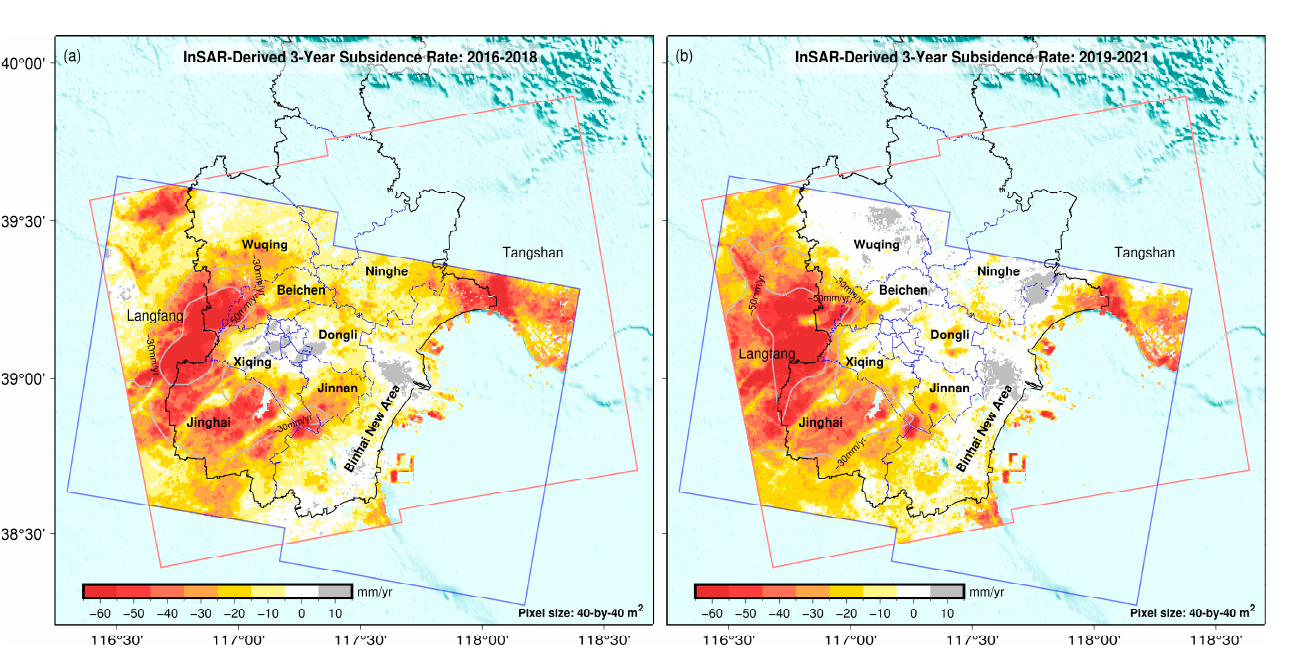
Figure 10. Comparisons of subsidence rates before and after the SNWD. ( a ) InSAR-derived 3-year subsidence rates from 2016 to 2018; ( b ) InSAR-derived 3-year subsidence rates from 2019 to 2021. The subsidence rates from 2016 to 2018 are similar with the subsidence rates before the arriving of Yang tz e water at the end of 2014.